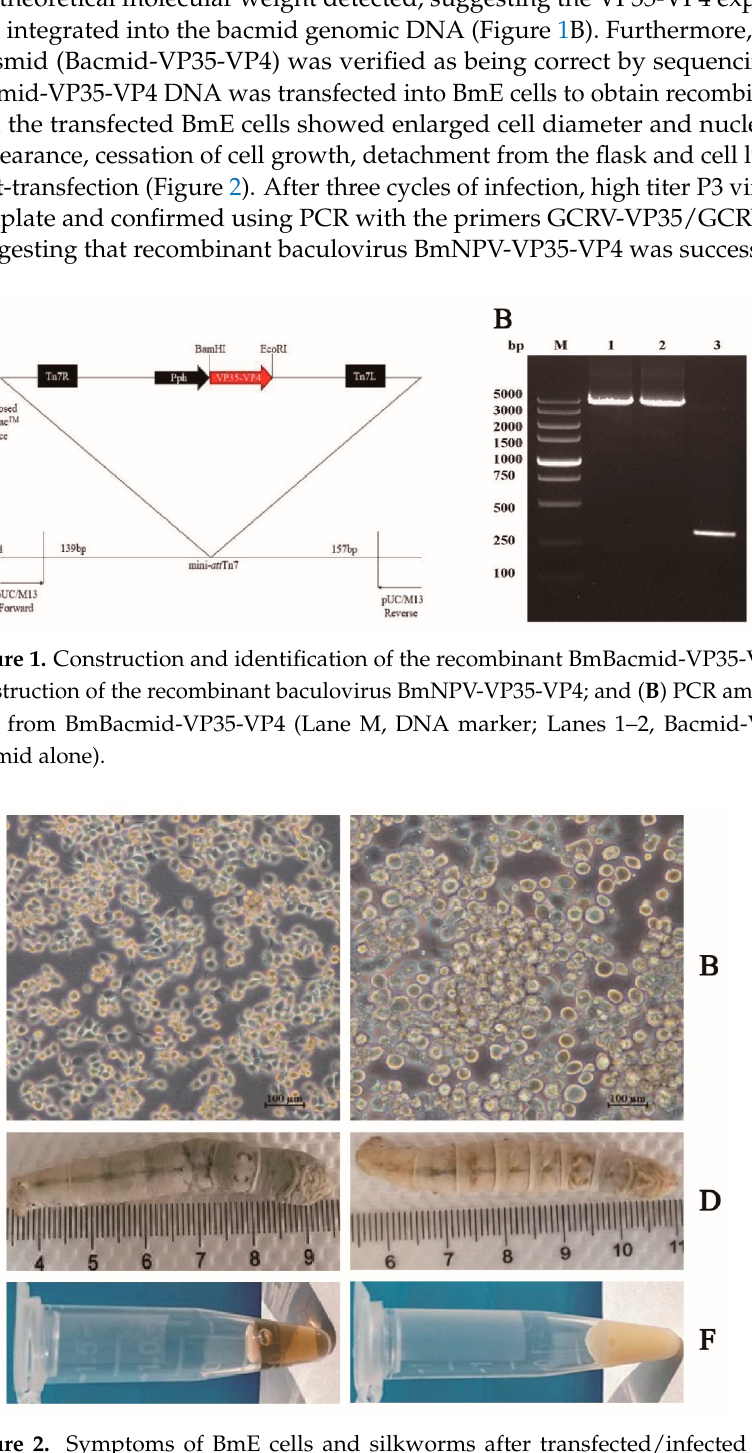
Figure 2. Symptoms of BmE cells and silkworms after transfected/infected with recombinant baculovirus: ( A ) normal BmE cells; ( B ) BmE cells transfected with recombinant BmBacmid-VP35-VP4; ( C ) normal silkworm; ( D ) silkworm infected with rBmBac-VP35-VP4; ( E ) hemolymph of normal silkworm; and ( F ) hemolymph of silkworm infected with rBmBac-VP35-VP4.